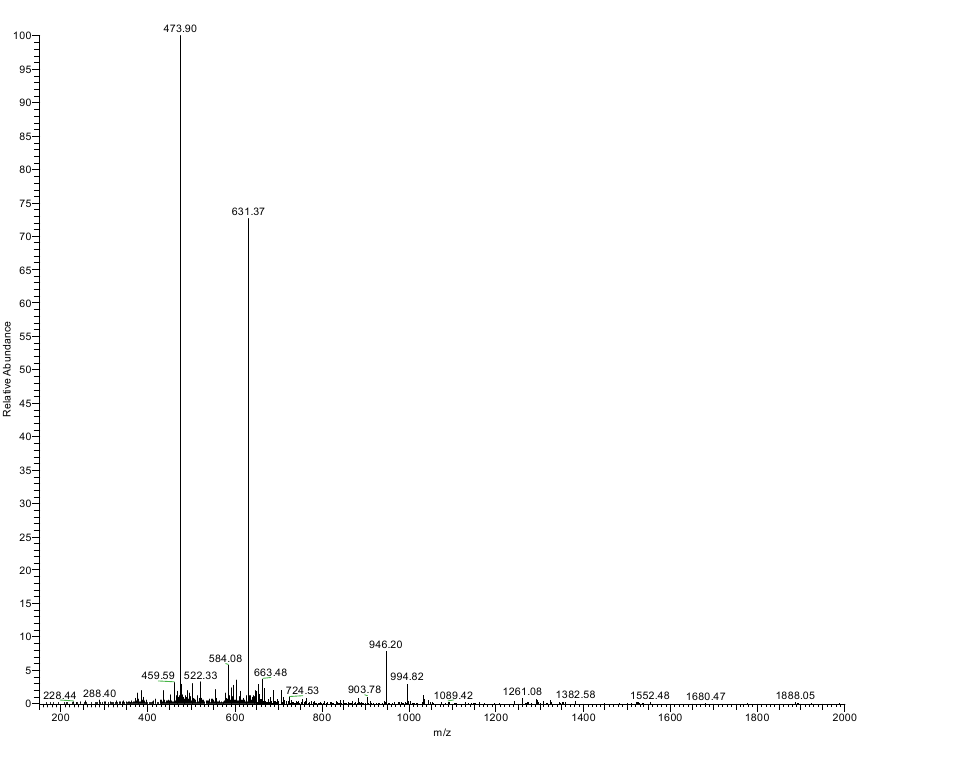
Figure 4. Electrospray MS spectrum of the novel peptide. m/z ion 473.90 is +4 charged (parent 1891.6), m/z ion 631.37 is +3 charged (parent ion 1891.2), and m/z ion 946.20 is +2 charged (parent ion 1890.4). Mean mass of parent 1891.1 vs. calculated of 1890.2 (discrepancy 0.05%).